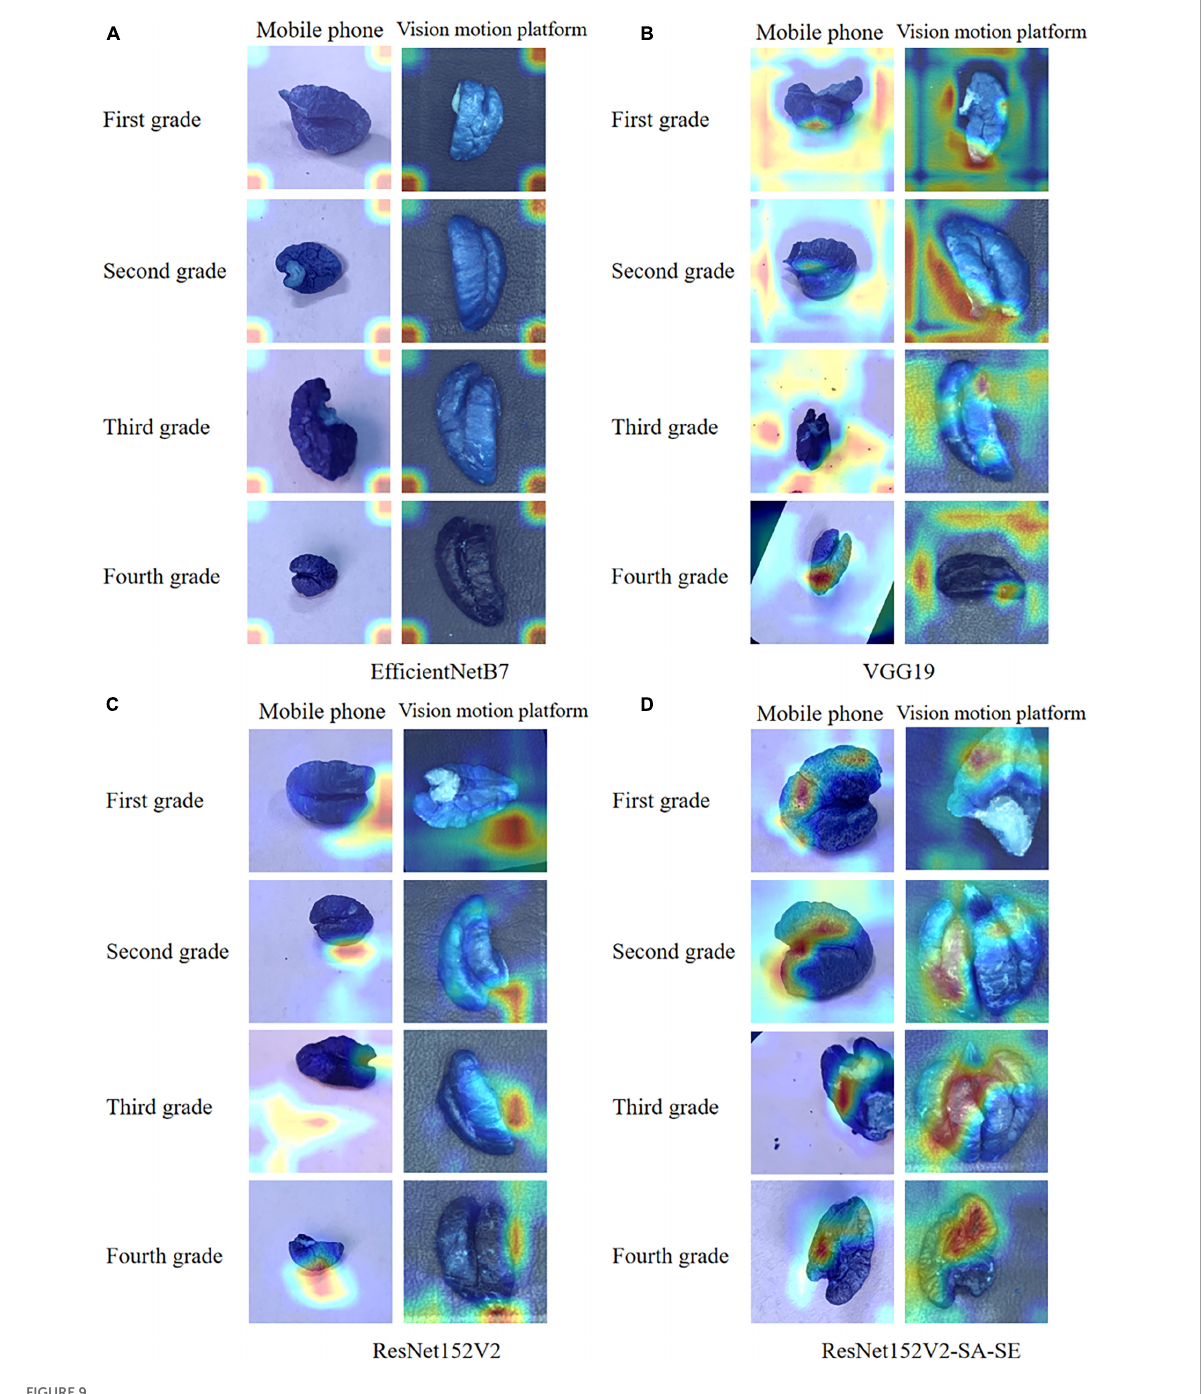
FIGURE9 (A) Heat map of the EfficientNetB7 model; (B) heat map of the VGG19 model; (C) heat map of ResNet152V2; and (D) heat map of ResNet152V2-SA-SE.